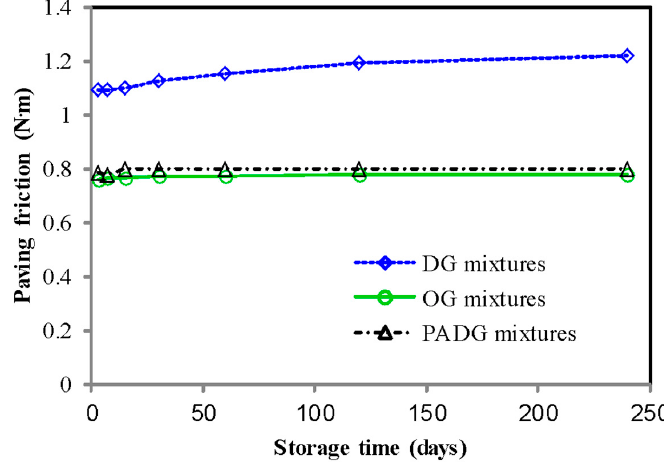
Figure 9. Paving frictions of cold mixtures at different storage times (at 5 °C ) .